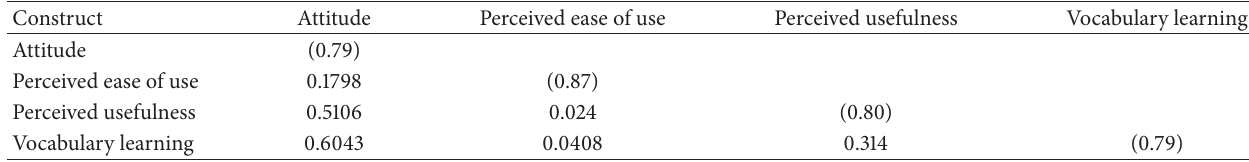
Table 4: Discriminant validity of the measurement model.